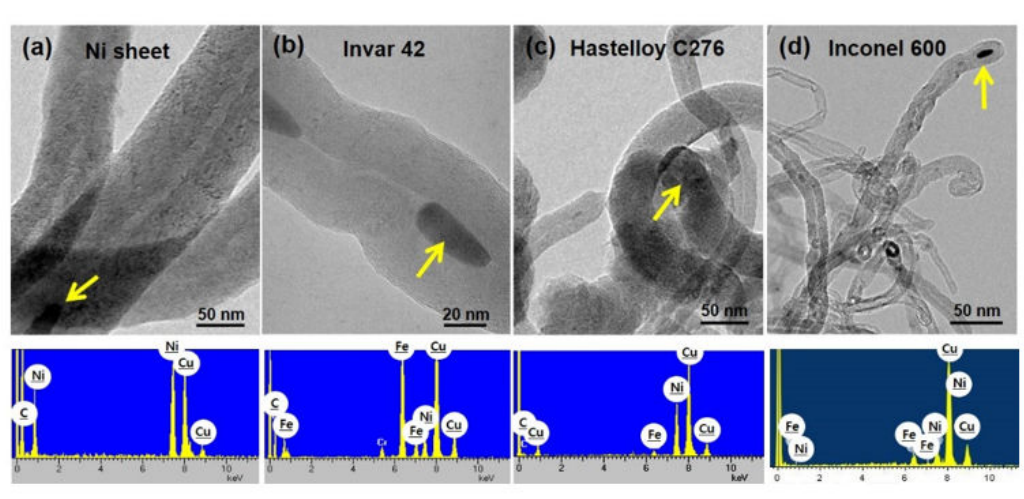
Figure 12. TEM images showing the detailed nanostructures of CNTs. ( a ) Ni sheet, ( b ) Invar 42, ( c ) Hastelloy C276 and ( d ) Inconel 600. EDS profiles are recorded from the catalytic nanoparticles indicated by arrows in each